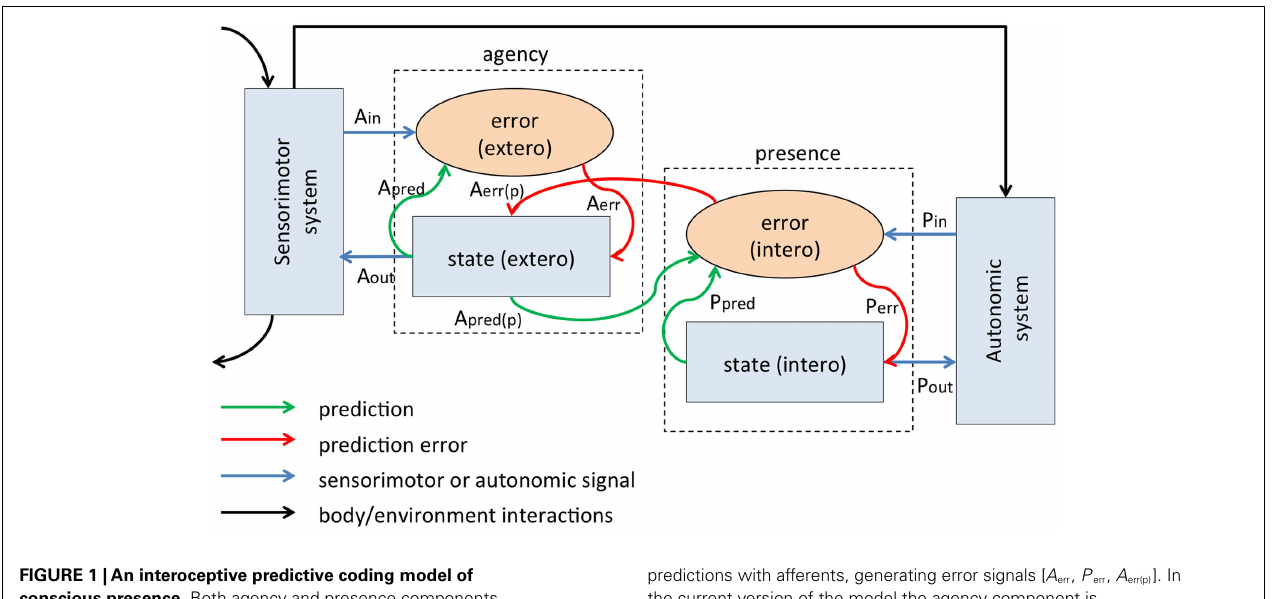
predictions with afferents, generating error signals [ A err , P err , A err(p) ]. In the current version of the model the agency component is hierarchically located above the presence component, so that it generates predictions about the interoceptive consequences of sensory input generated by motor control